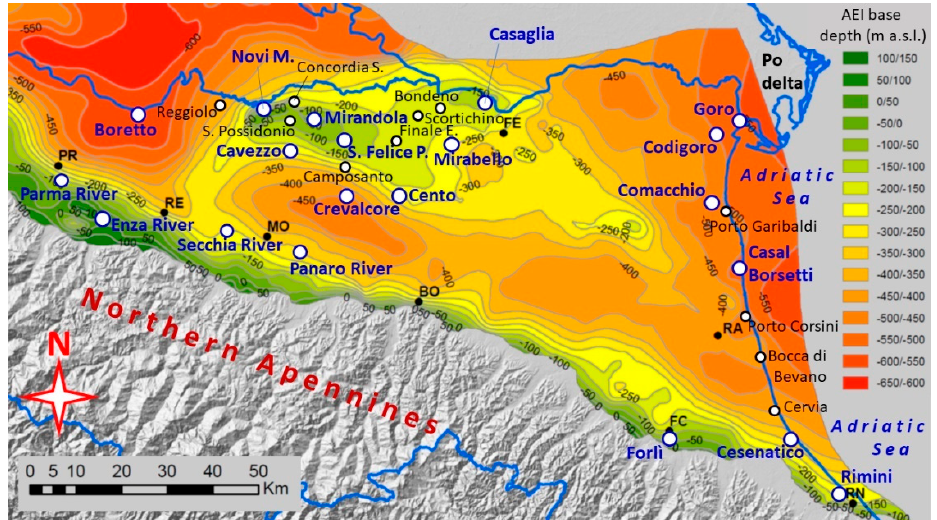
Figure 6. Location of the case studies (white dots). Larger symbols and blue toponyms indicate sites with geophysical/geotechnical tests and geological cross-sections; smaller symbols and black toponyms indicate sites with only geophysical tests.